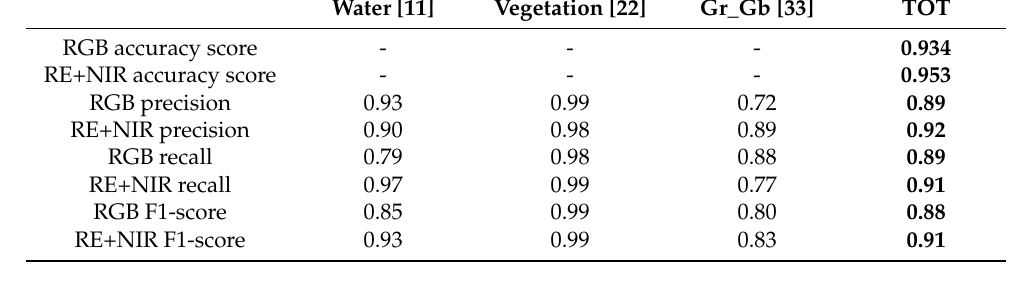
Table 5. Third classified cloud accuracy parameters obtained.